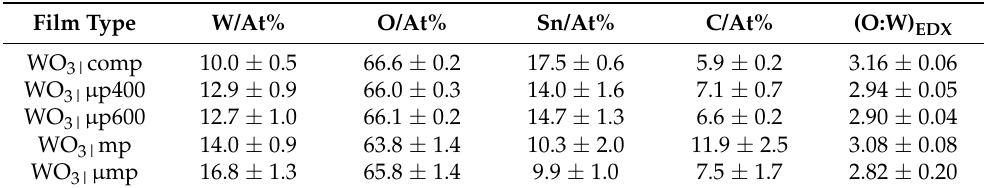
Table 2. Average elemental composition (and standard deviation) of the different tungsten oxide thin films obtained from EDX and the calculated (O:W) EDX ratios.